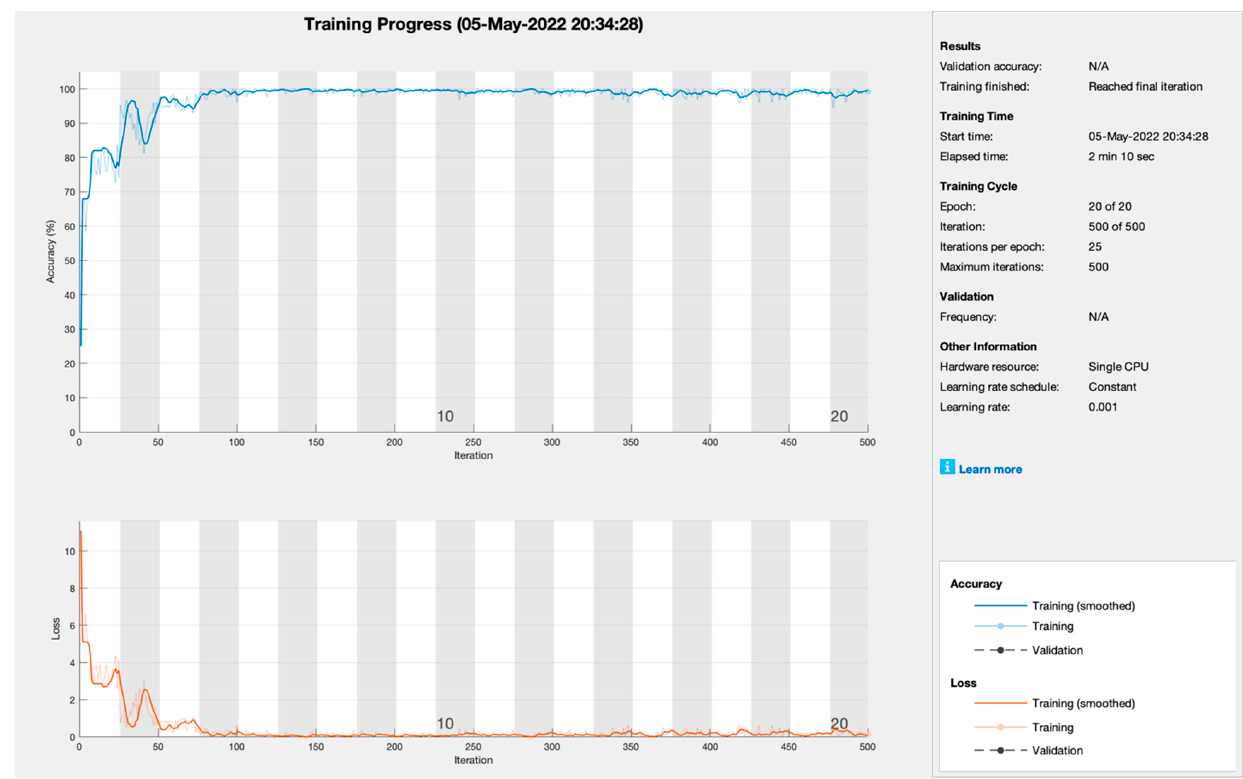
Figure 4. Training progress of SGDM empowered with AlexNet to predict kidney cancer.